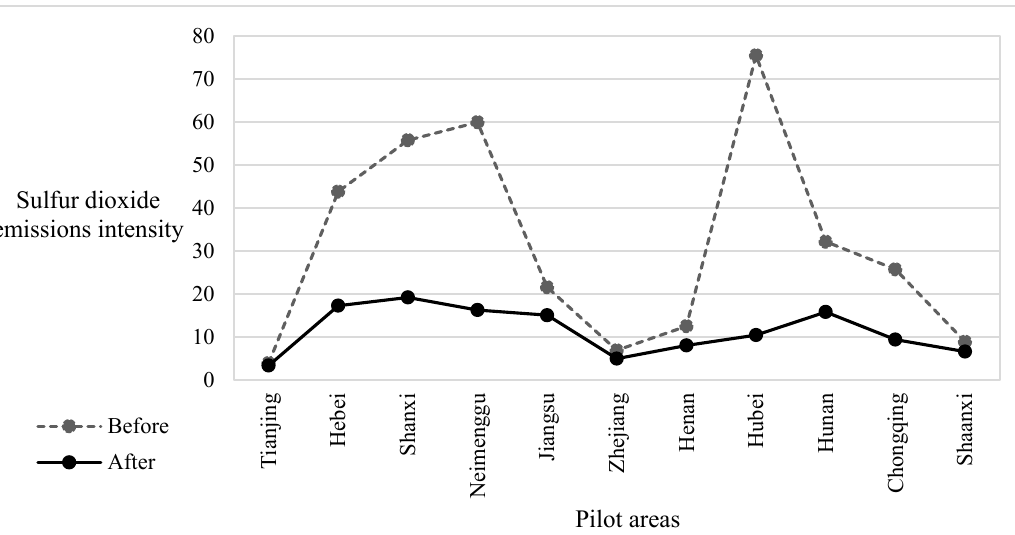
Figure 3. Comparison of SO 2 emissions before and after the implementation of the policy. Second, to observe the relationship between the SO 2 ETS and the environmental per- formance of enterprises, we draw a comparison chart of the average environmental per- formance level of enterprises in the pilot areas before and after the implementation of the policy. The mean value of the SO 2 emissions intensity of pilot areas in the 5 years before (or after) the implementation of the policy is selected to represent the average perfor- mance level of enterprises before (or after) the implementation of the policy, which is rep- resented by the dotted line (or the solid lines) in the Figure 4. As shown in Figure 4, the dotted line is always above the solid line, indicating that after the implementation of the policy, the average SO 2 emissions intensity of enterprises in the pilot area has been re- duced, and the environmental performance of enterprises has improved. Therefore, we preliminarily determine that the SO 2 ETS can improve the environmental performance of pilot areas.